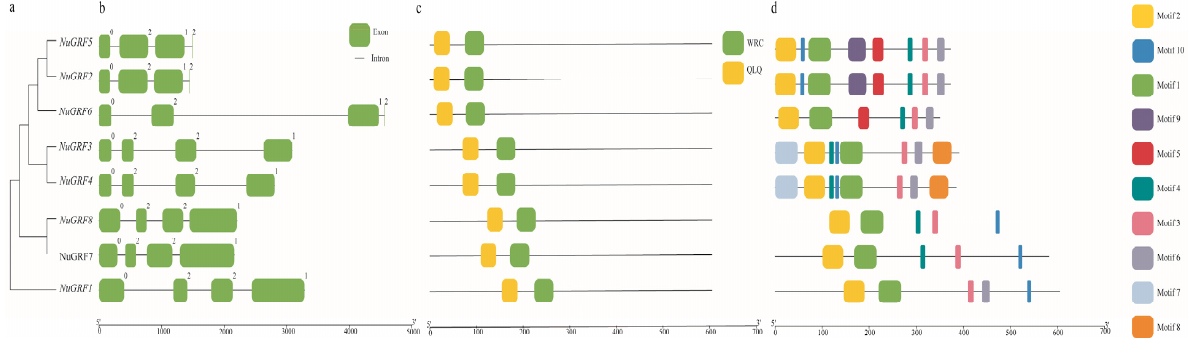
Figure 2. Phylogenetic tree, gene structure, conserved domains, and conserved motifs of GRF genes. ( a ) Phylogenetic tree of NuGRFs. ( b ) Gene structure of NuGRFs, with black lines and green blocks representing upstream or downstream untranslated regions (UTR) and exons, respectively. ( c ) Conserved domains of NuGRFs. ( d ) Predicted motifs of NuGRFs.